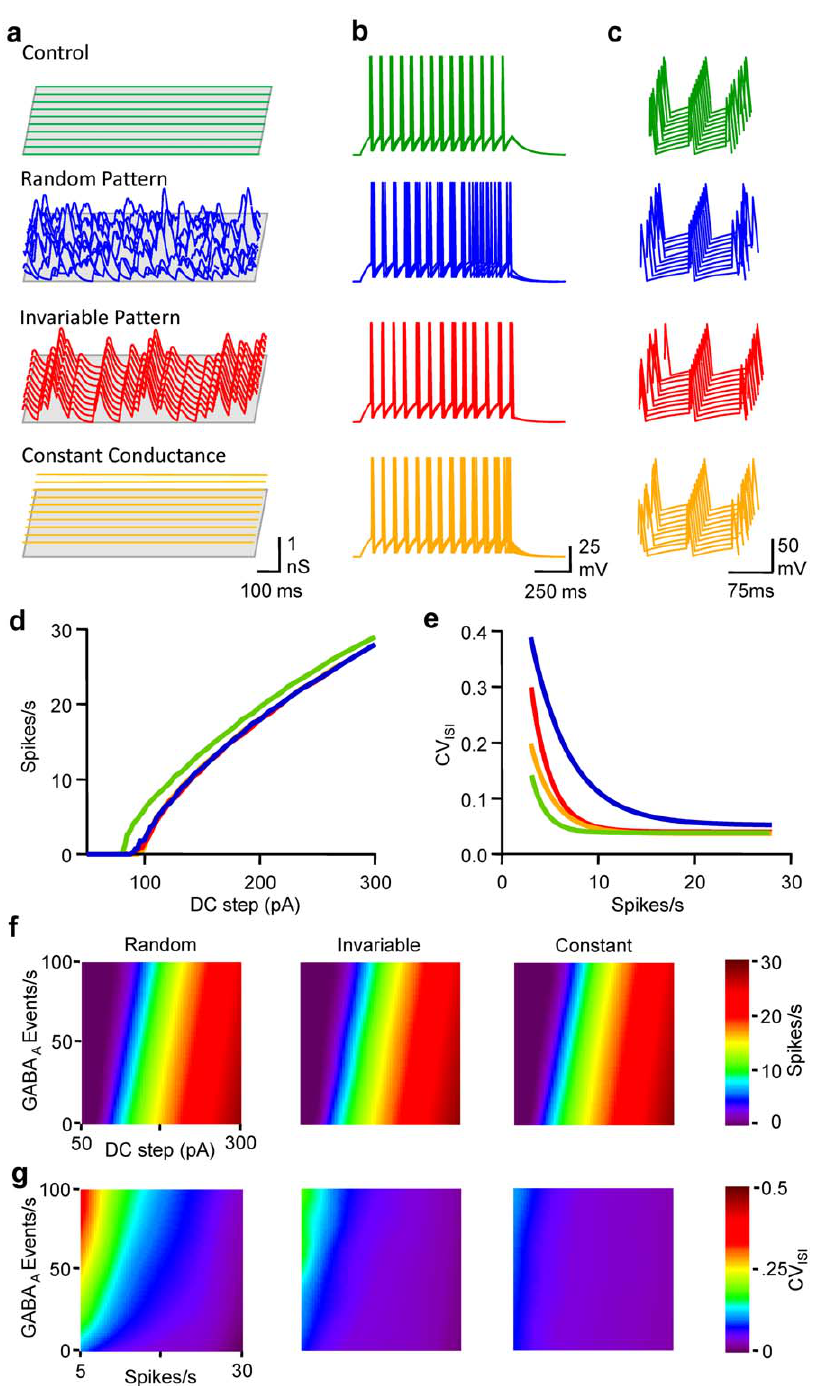
Figure 4. Randomly occurring GABA A conductance transients underlie the frequency-dependent tuning of pyramidal cell discharge fidelity. a, Waterfall view of conductance fluctuations injected into the LIF model in control conditions (no conductance, green), when the LIF model received 33 randomly occurring GABA A events/s (blue), an invariable pattern of 33 GABA A events/s (red), or when the neuron model received a constant G GABA-A equivalent to the average conductance for a rate of 33 events/s (orange). Same cell and colour code for b,c,d and e. b, Superimposed (5) Vm fluctuations of the LIF model in response to a DC step (1 s, 160 pA) in the various conditions depicted in a. c, Waterfall view of Vm when the 5 th spike was set as the time reference. d, Mean firing rate vs DC step. e CV ISI vs firing rate. f, Mean firing rate displayed on a pseudocolor scale vs DC step and rate of GABA A activity when LIF model received random (left), invariable (middle) or constant conductance (right). g, CV ISI displayed on a pseudocolor scale vs firing and GABA A activity rate. Same conditions as in f.